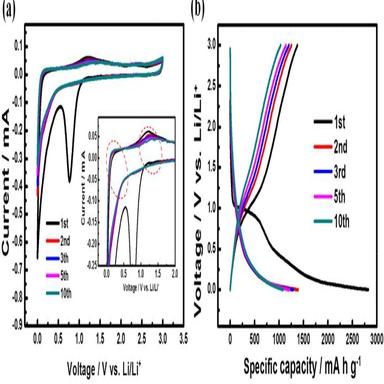
(a) Cyclic voltammetry curves of cPAN nanofibers at 0.1 mV s−1 . The inset is the enlarged pictures of two broad peaks at 0.01–0.3 V and 0.6–1.2 V. (b) Galvanostatic discharge/charge profiles of cPAN nanofibers at 0.05 A g−1 in 0.001–3.0 V (vs. Li+/Li).